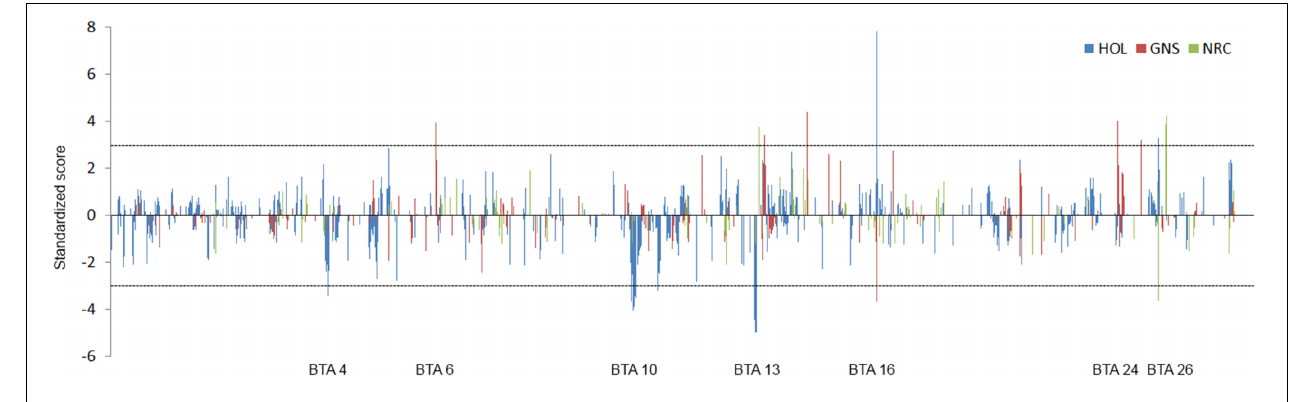
FIGURE 3 | Migration of the most frequent haplotypes from parental breeds to Kenyan crossbreds. The standardized score of haplotype migration of Holstein (blue), Guernsey (red), and Norwegian Red (green) are shown across the genome. Positive score represents